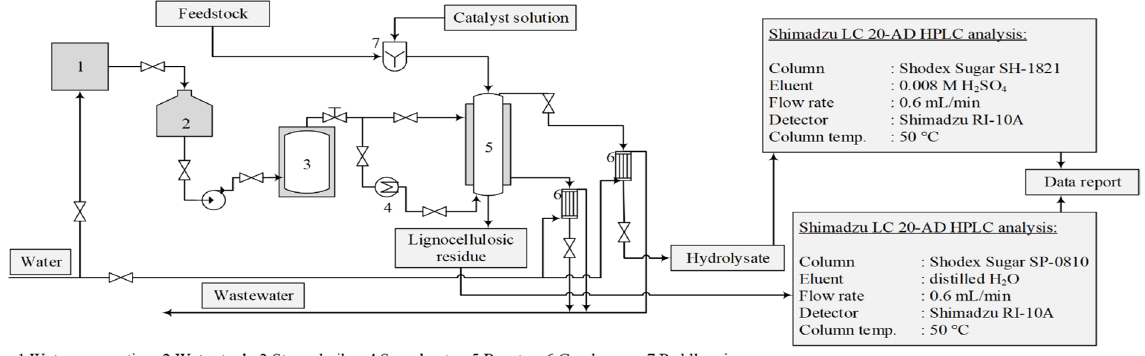
Figure 1. Acid hydrolysis reactor system and experimental procedure for obtaining hydrolysis prod- ucts.